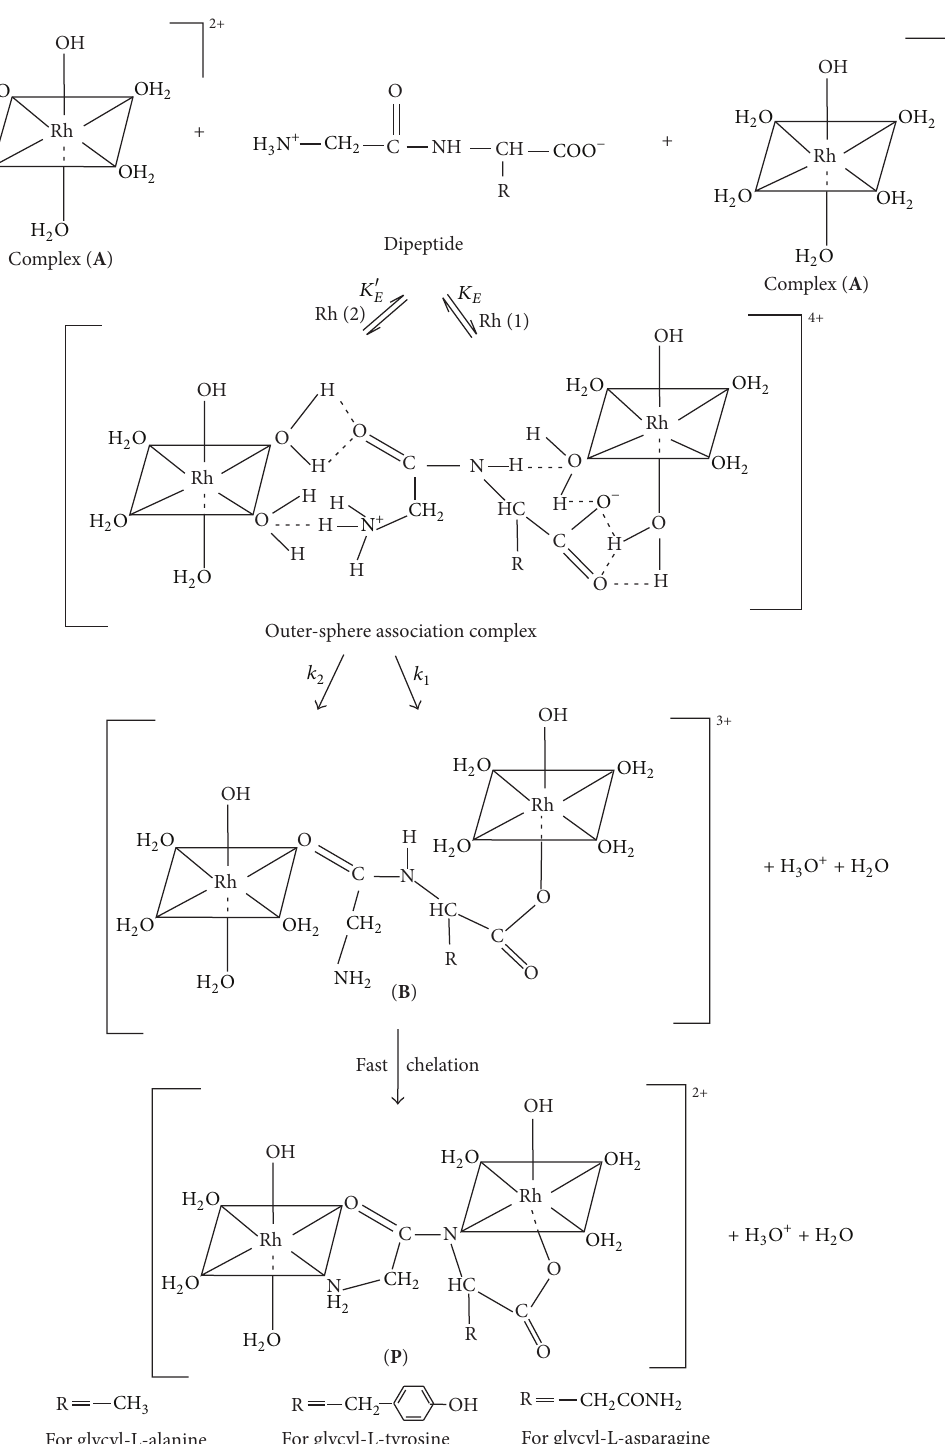
Figure 9: Proposed mechanism for the interaction of dipeptide with the complex A